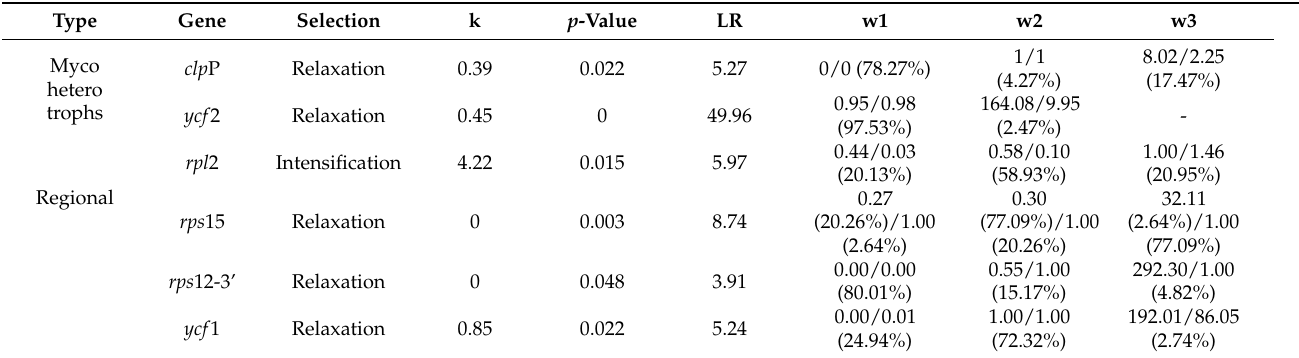
Table 3. Estimated selection pressure in the result of RELAX. Regions with significant p-values are listed in the